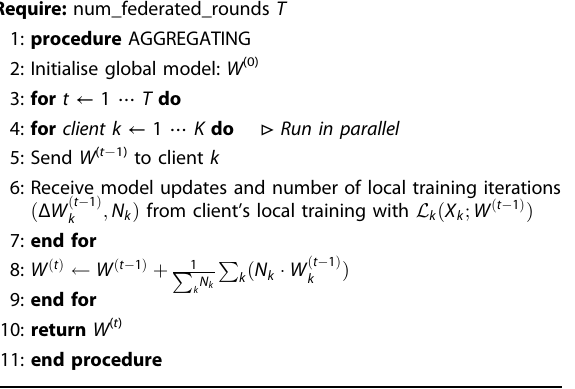
Algorithm 1 . Example of a FL algorithm 16 via Hub & Spoke (Centralised topology) with FedAvg aggregation 9